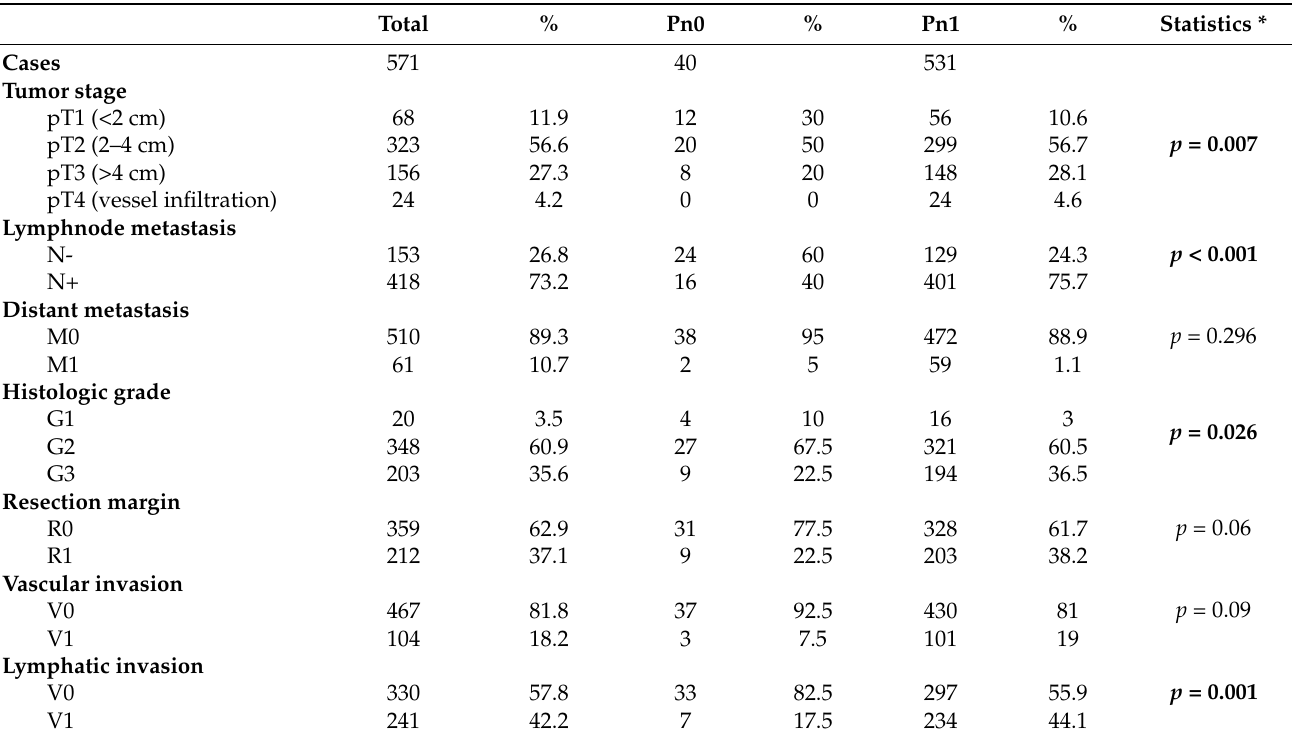
Table 2. Histopathological assessment of tumors in Pn0 and Pn1 groups.